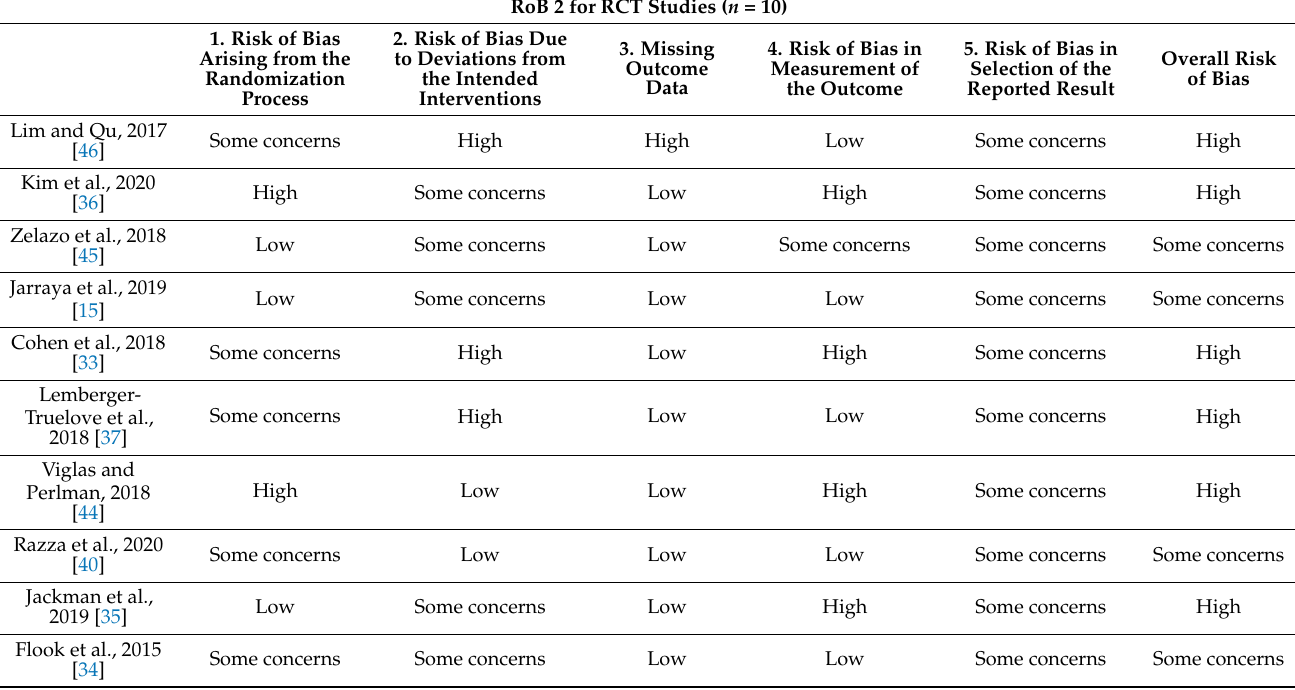
Figure S4: Risk of bias summary for